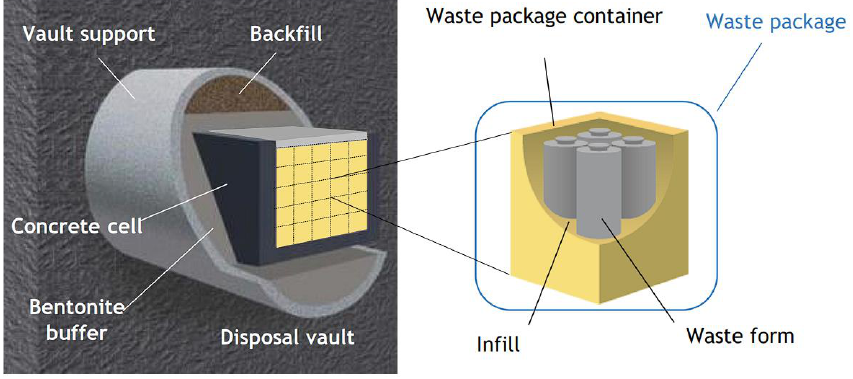
Figure 13. Illustration of transuranic radioactive waste emplacement in Japanese project of geological disposal facility [58]. It is planned to place transuranic radioactive waste canisters inside the container, after which the cement mortar is poured. The containers will be placed in a concrete lined